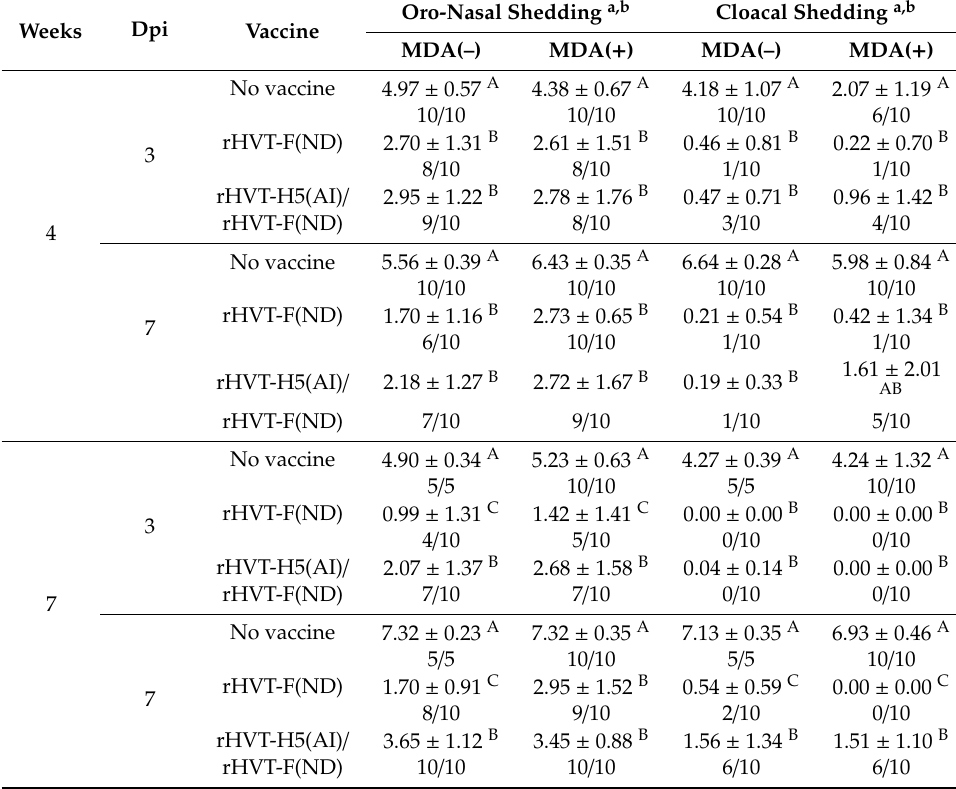
Table 4. Oro-nasal and cloacal shedding of vNDV after challenge at 4, 7, and 10 weeks of age with the vNDV of LBL layer chickens (experiment II) vaccinated at day-old with the rHVT-F(ND), the rHVT-H5(AI) or both